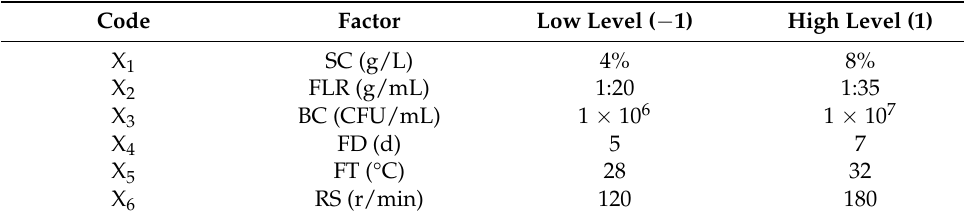
Table 1. Plackett–Burman experimental design factor levels and codes.